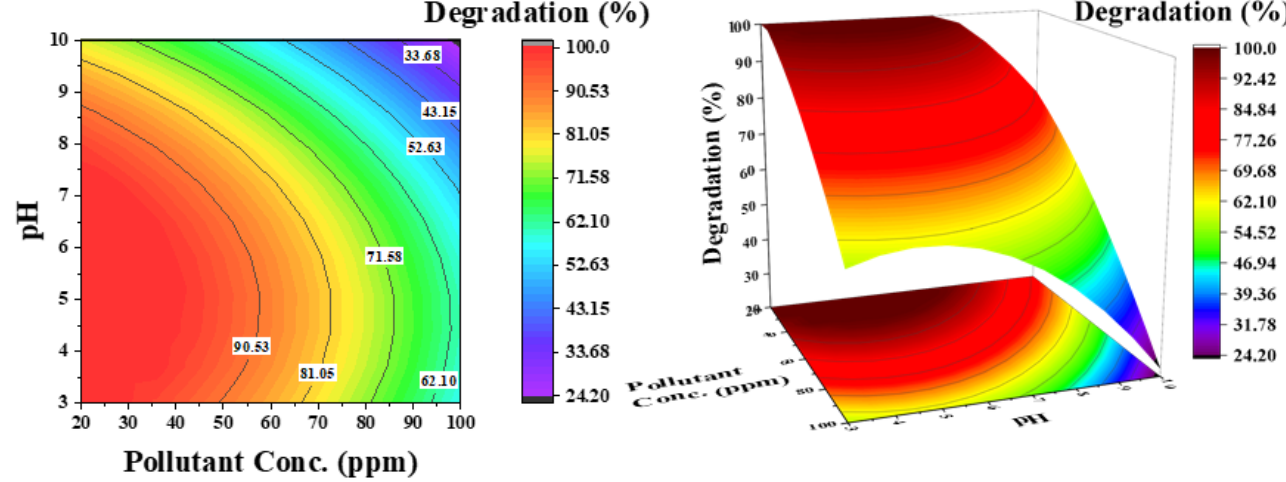
Figure 8. Effect of pollutant concentration and pH on the degradation of phenol: catalyst concentration was kept constant at 0.5 g/L.